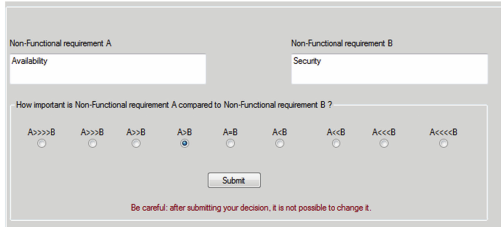
Figure 5: A snapshot of the graphical user interface showing a pair of nonfunctional requirements (availability, security) under evaluation in CHAM.